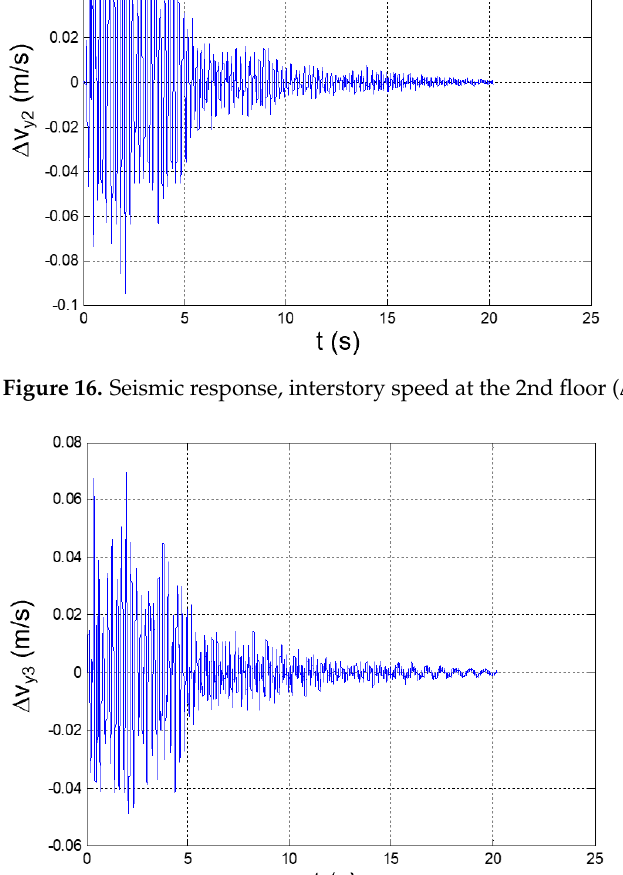
respect to the ground).